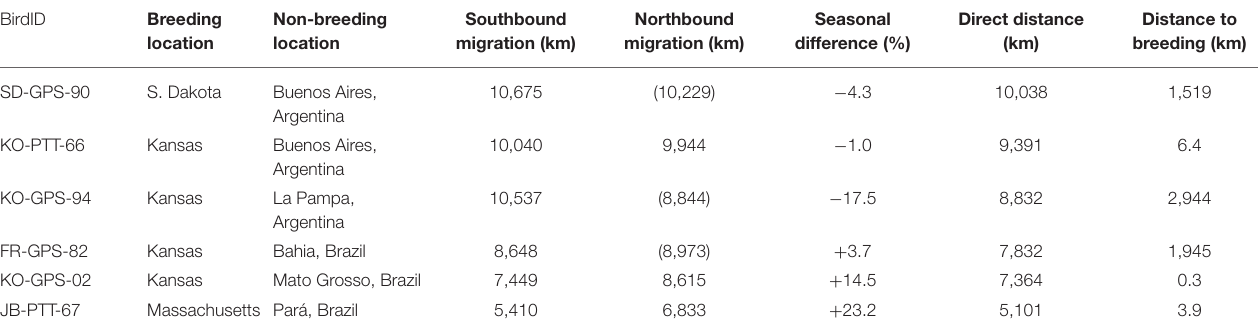
TABLE 2 | Summary of migration distances throughout the annual cycle for six Upland Sandpipers from 24 April 2016 to 1 May 2017, including the southbound and northbound migration distances, and the difference (%) between the two migration routes. BirdID Breeding Non-breeding Southbound location location migration (km)